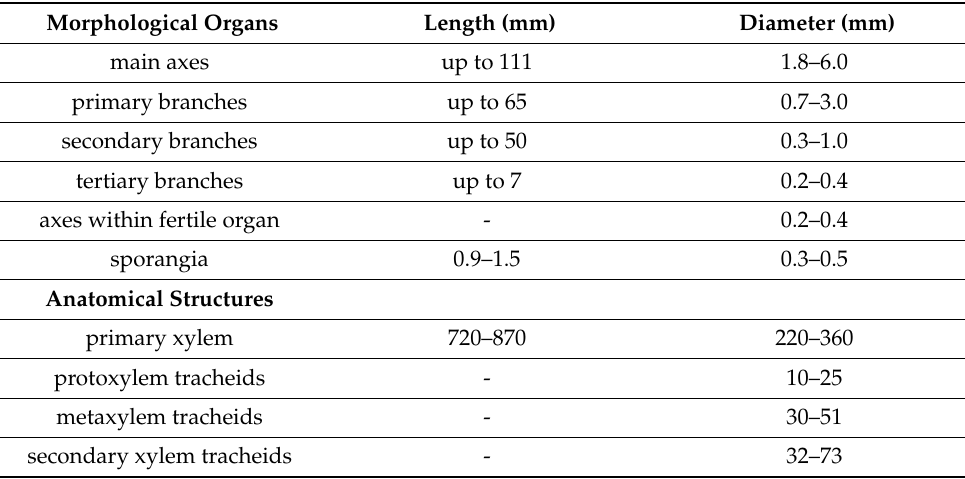
Table 1. Measurements of morphology and anatomy of Xinhangia spina